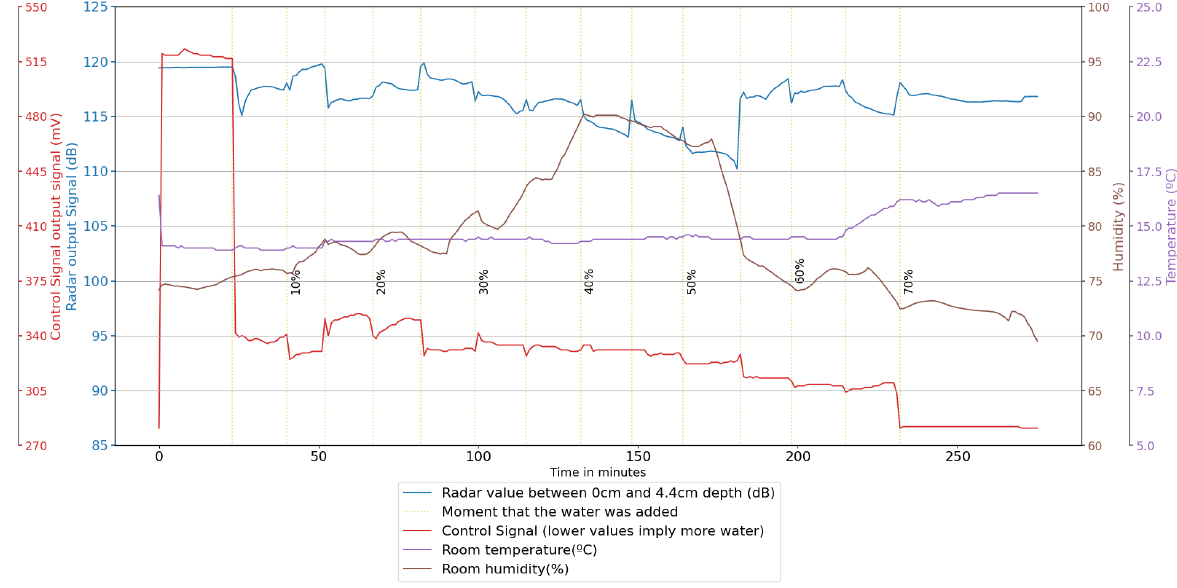
Figure 7. Experiment 3 results in the sealed container. The vertical yellow dotted lines represent the moments when the water was added, and the brown color represents the container air humidity. The blue line corresponds to the RADAR’s signal, and the red line corresponds to the control